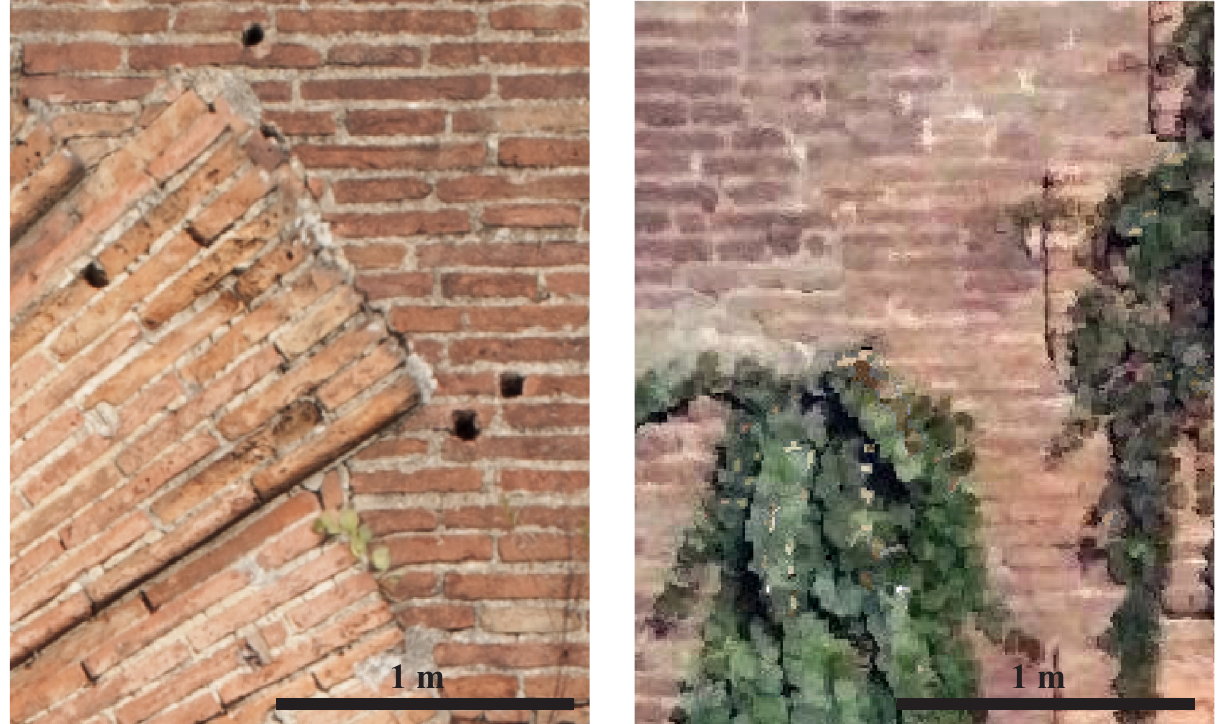
Figure 6. A sample of ortophoto (left, by a photogrammetric processing) and of ortoimage (right, by laser scanning processing) - the sampling are enlarged to make evident the difference between orthophoto and orthoimage; at the original print scale (1:100) the images quality is almost equivalent.